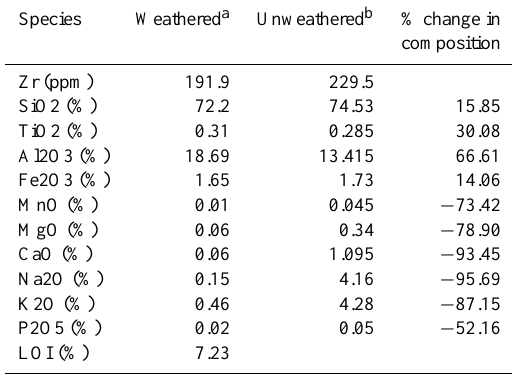
Table 4. Major element (wt%) composition of weathered and unal- tered granite from the study